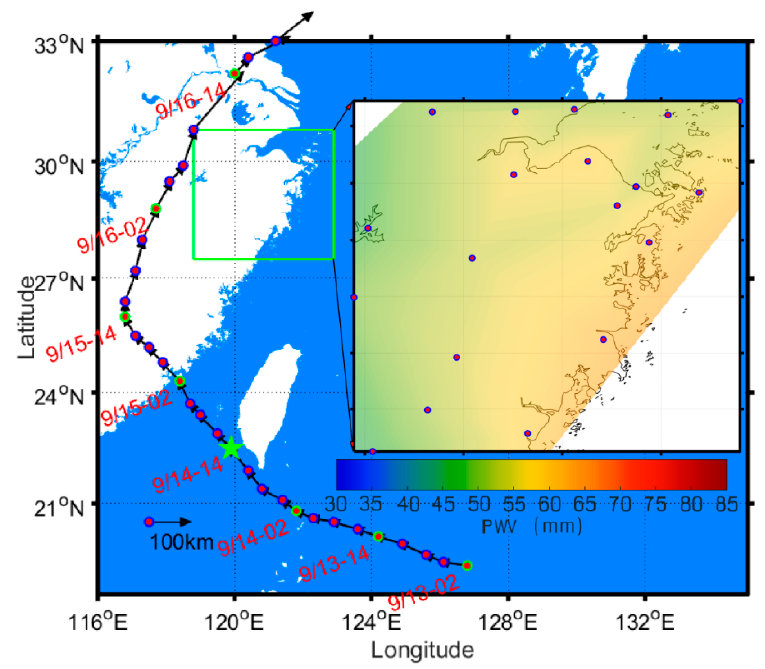
Figure A2. PWV distribution in Zhejiang province at 14:00 on 14 September 2016.